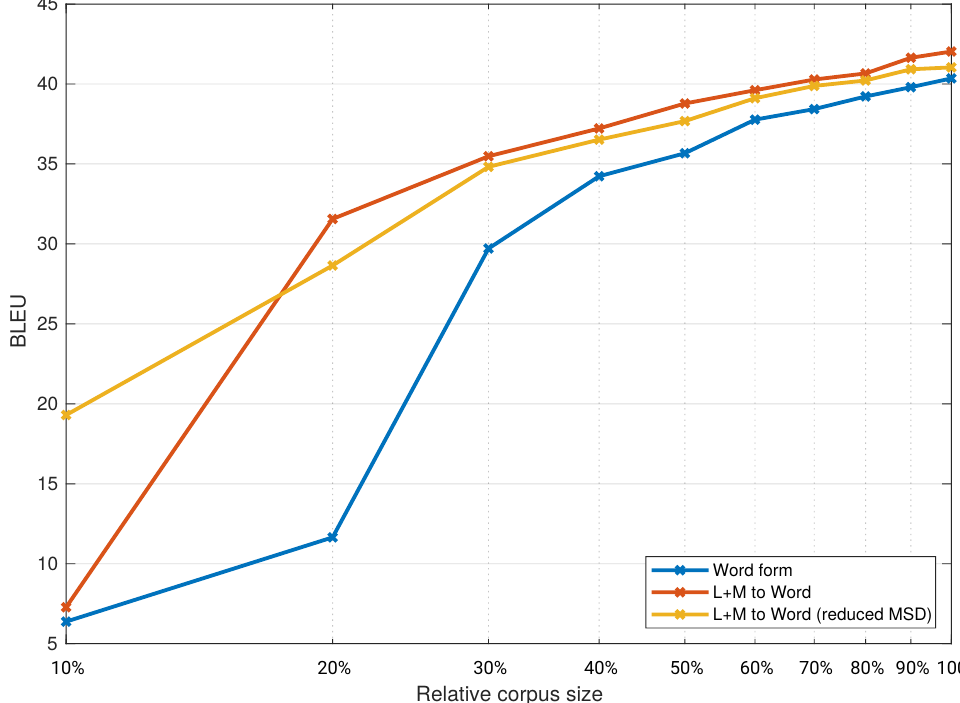
Figure 2. Translation results for the selected translation systems from Slovene to English using Europarl with respect to relative training corpora